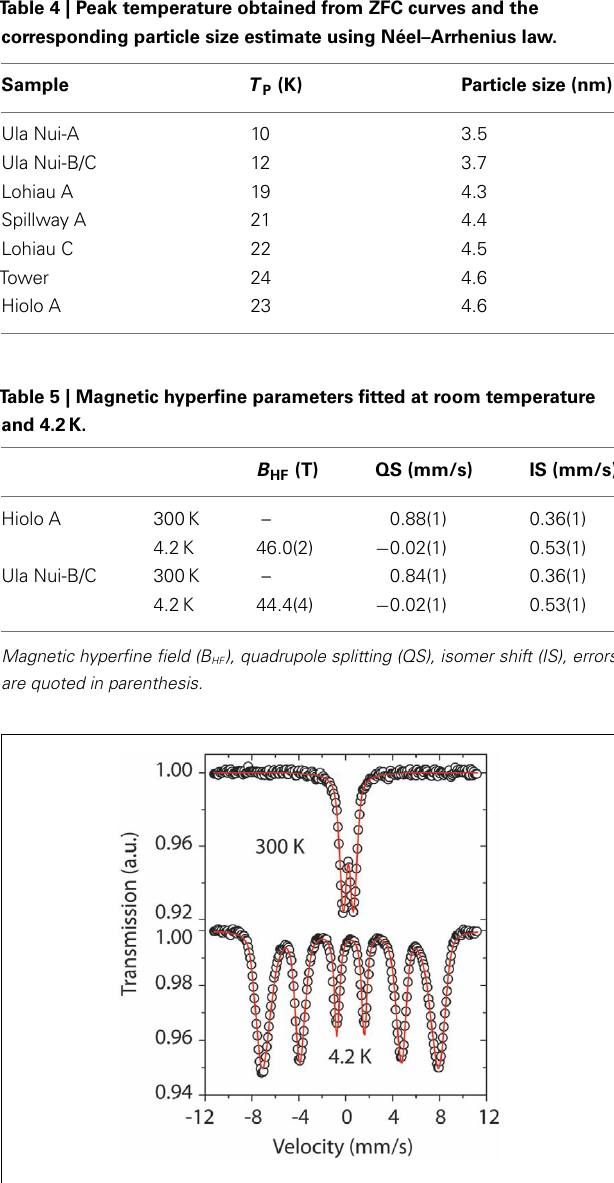
FIGURE 8 |The Mössbauer spectra show the typical behavior of Loihi Fh SRO . At room temperature the spectrum is represented by a doublet and indicates the presence of Fe 3 + . At 4.2K the spectrum is a sextet and indicates magnetic order.The sextet has broad lines suggesting the Fe phase is poorly crystallized.The doublet at room temperature represents a phase in a superparamagnetic